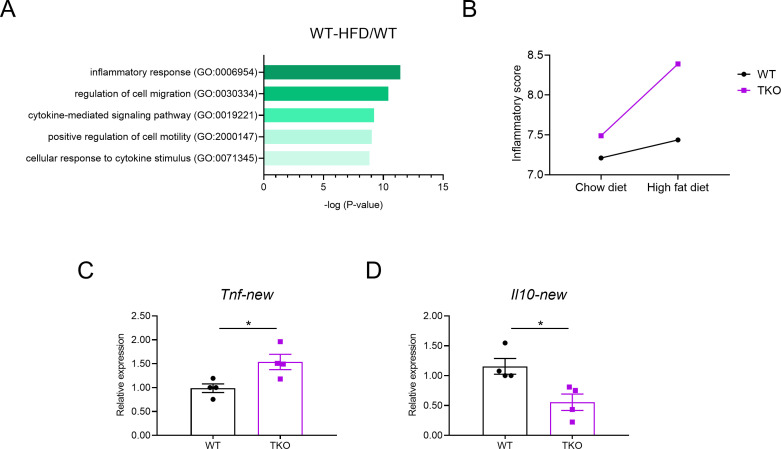
Adipose tissue macrophages (ATMs) in TKO mice are more inflammatory.(A and B) WT and TKO mice were fed with regular chow diet or high-fat diet (HFD) for 8 weeks; ATMs were sorted for a genome-wide RNA profiling analysis. (A) Gene ontology analysis of RNA-seq datasets of ATMs from WT mice fed with chow diet or HFD. (B) Inflammatory score of WT and TKO mice fed with chow diet or HFD. Inflammatory score = sum of log (FPKM+1) of representative pro-inflammatory genes (Tnf, Il6, Cxcl1, Ccl2, and Ccl8) − sum of log (FPKM+1) of representative anti-inflammatory genes (Il10, Il4, Il5, and Il13). (C and D) qPCR analysis of Tnf (C) and Il10 (D) mRNA with an additional set of primers in WT and TKO ATMs. *p<0.05 (unpaired Student’s t-test). Data are representative of one (A and B) or are pooled from two (C and D) independent experiments (mean ± s.e.m.).